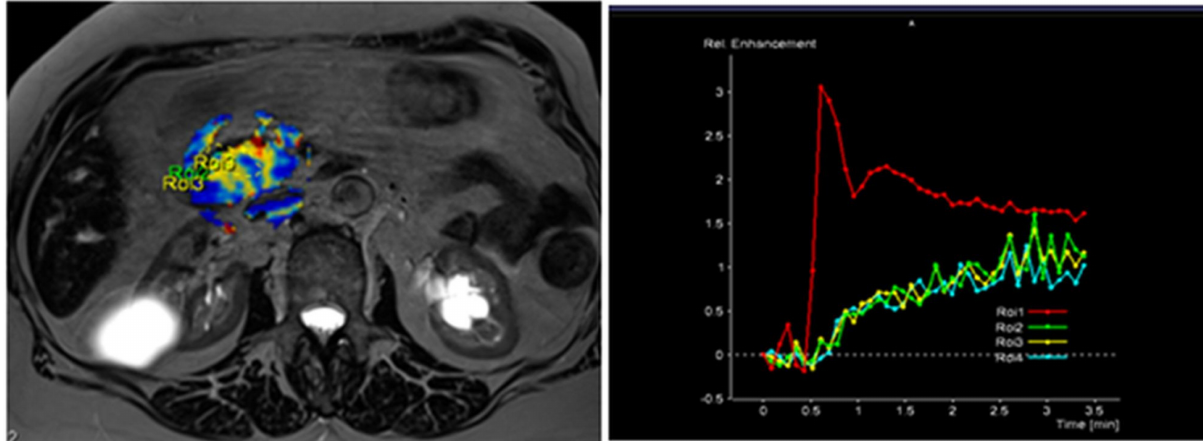
Figure 3. MRI perfusion images of G3 tumor in the head of the pancreas with TSIC—type II (slow enhancement and then continuous enhancement). The curve graph shows that pancreatic tumor enhances to a lesser extent than surrounding nontumoral pancreatic tissue. Most poorly differentiated (G3) tumors showed Type II pattern